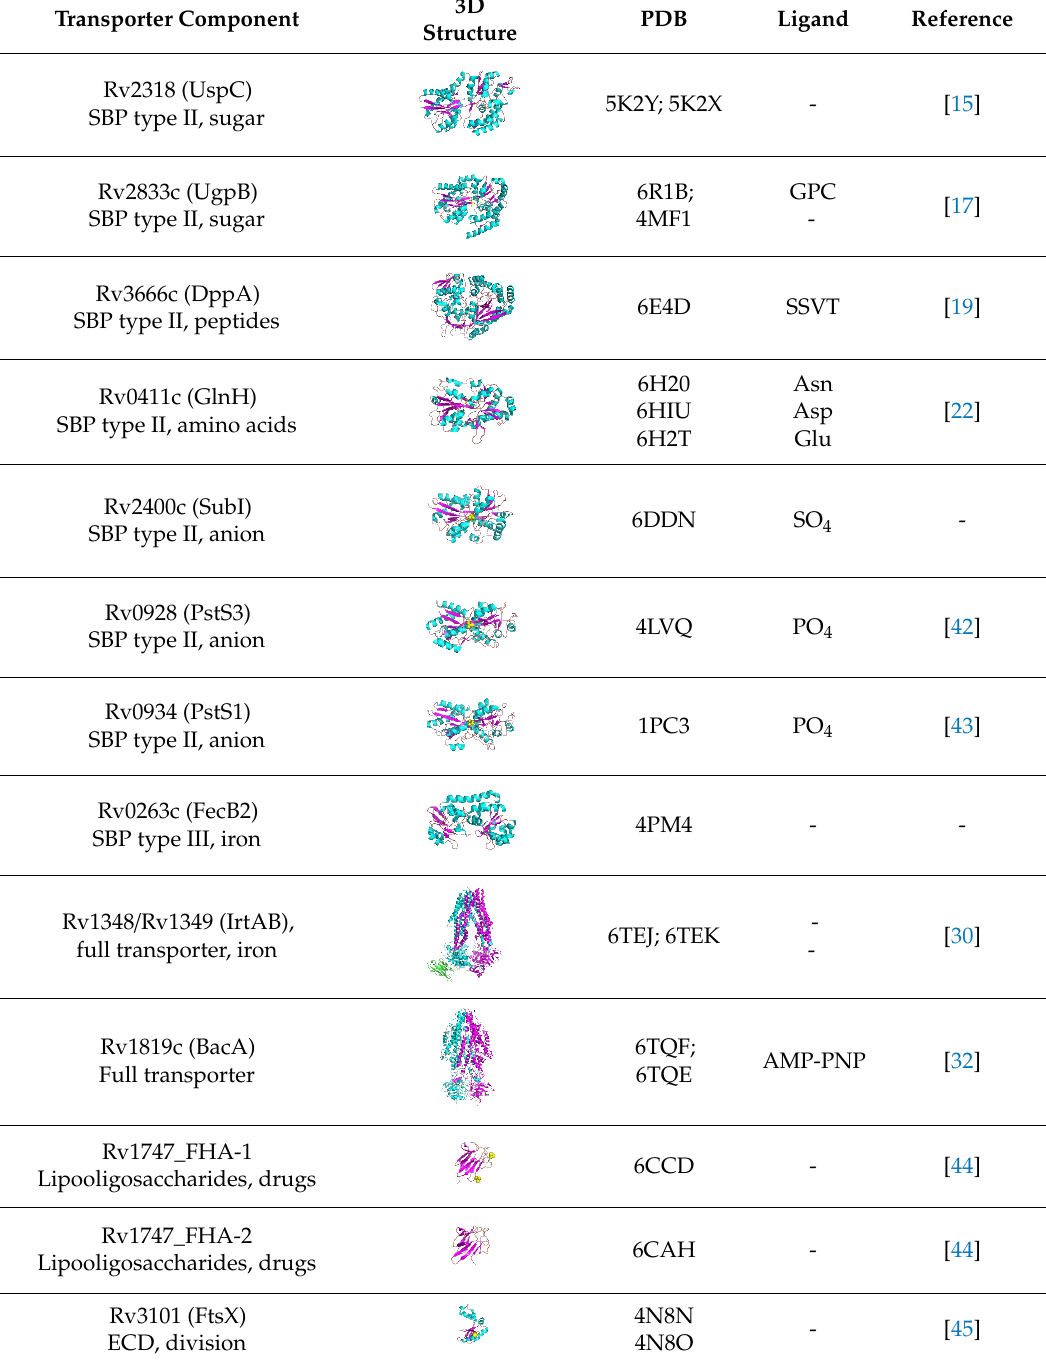
Table 2. M. tuberculosis ABC transporters whose structure was solved. FHA-1 and FHA-2: Fork-Head Associated domains (1 and 2) from the Rv1747 transporter; SBP: substrate-binding protein; ECD: extracellular domain.